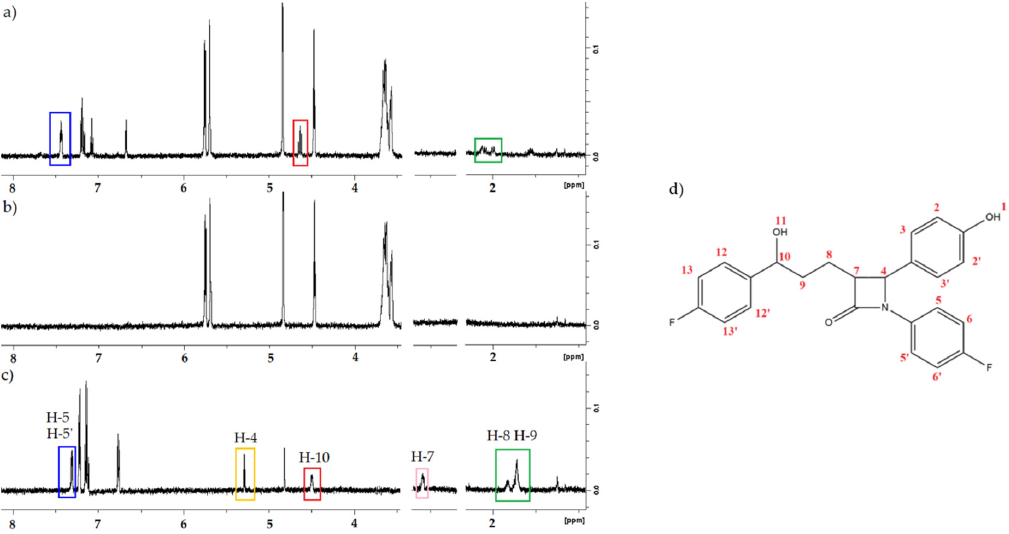
Figure 8. Spectra 1 HNMR of ( a ) β -CD/EZE complex, ( b ) β -CD, ( c ) EZE; ( d ) protons assignment in the ezetimibe structure.